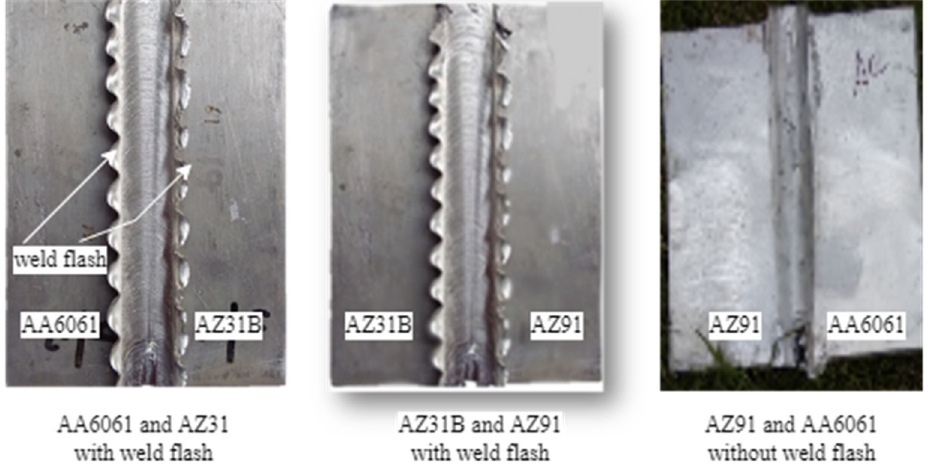
Figure 2. FSW joint view with or without flash.